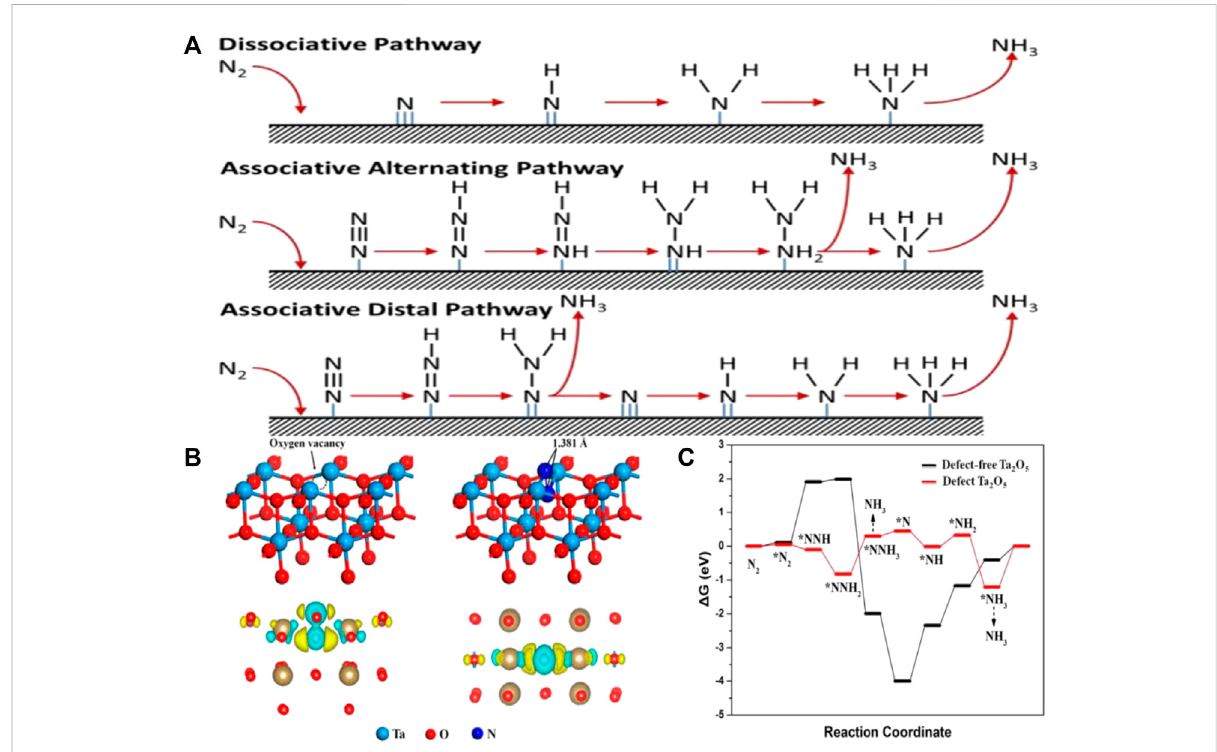
FIGURE 1 (A) Possible reaction mechanisms for the NRR to form NH 3 . (Shipman and Symes, 2017) with permission from Copyright 2016 Elsevier B.V. (B)